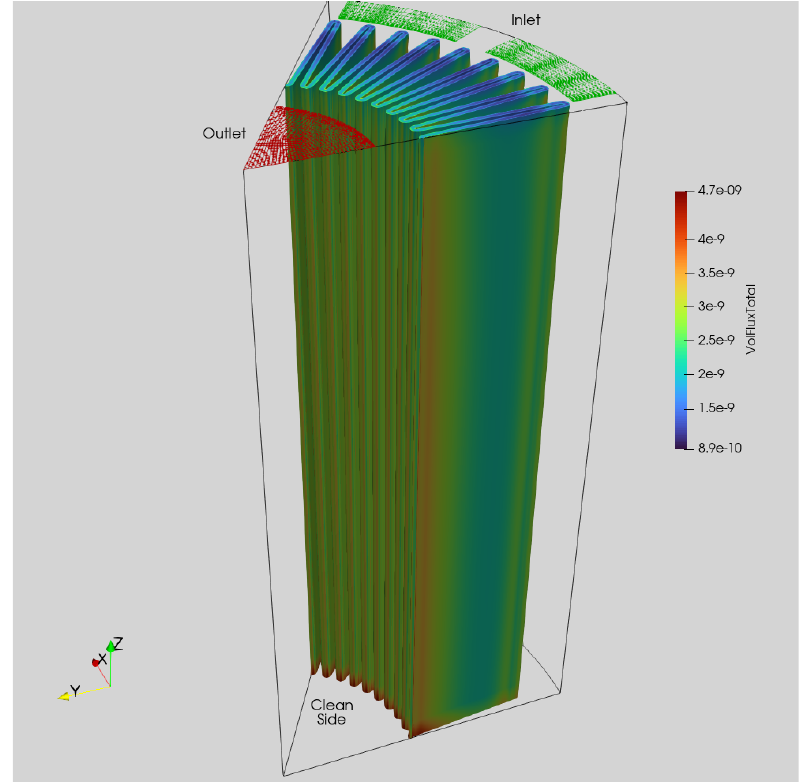
Figure 3. Flux of particle mass arriving at the filtering